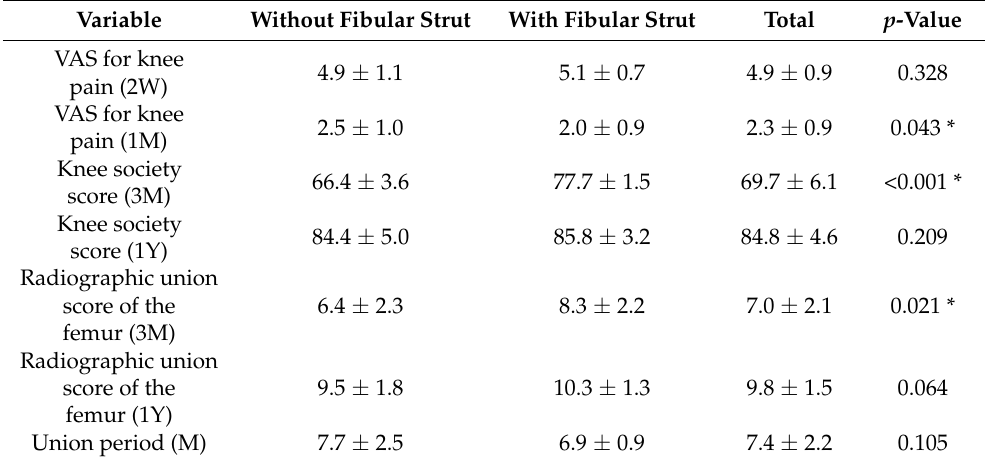
Table 2. Postoperative functional evaluation of both groups ( n = 124).